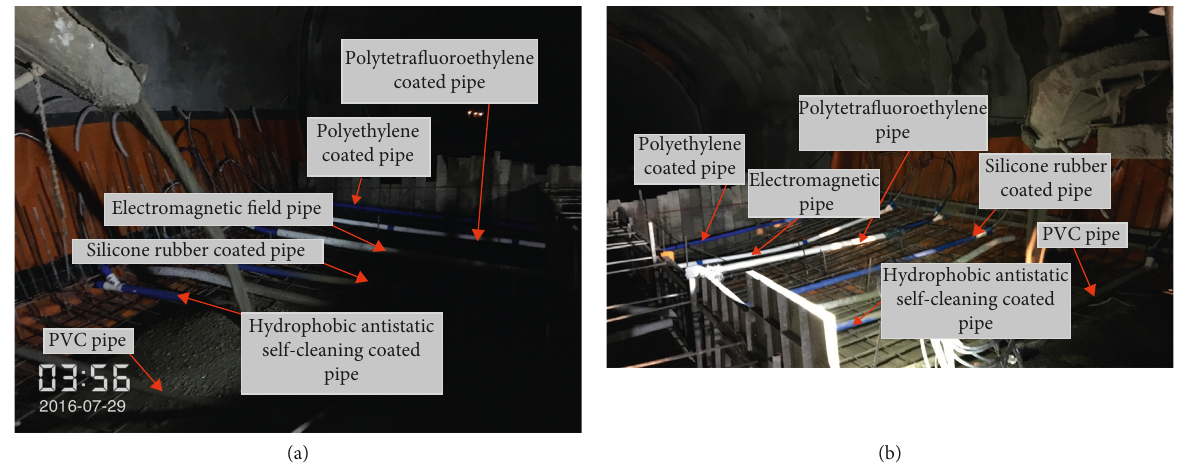
Figure 7: The field layout of the target pipes. (a) Left side. (b) Right side.